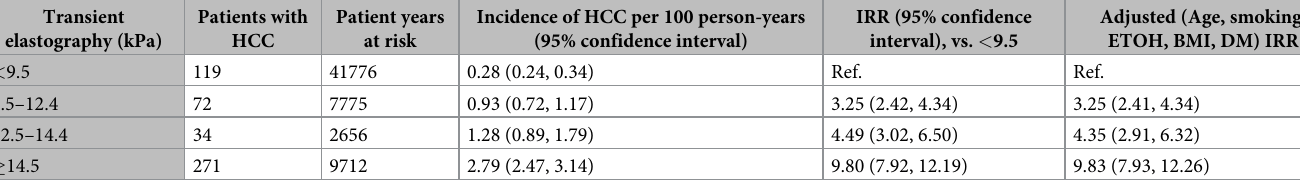
HCC in the NAFLD subgroup Among those tested with liver elastography meeting our inclusion criteria, 13,629 had a diag- nosis of NAFLD. Within that population, 42 had chart-review confirmed HCC. Fig 2 displays the incidence of HCC for each cohort of patients based on TE score. For TE scores < 9.5 kPa, Table 2. Incidence of HCC in veteran population with HCV based on TE score. Transient Patients with Patient years Incidence of HCC per 100 person-years elastography (kPa) HCC at risk (95% confidence